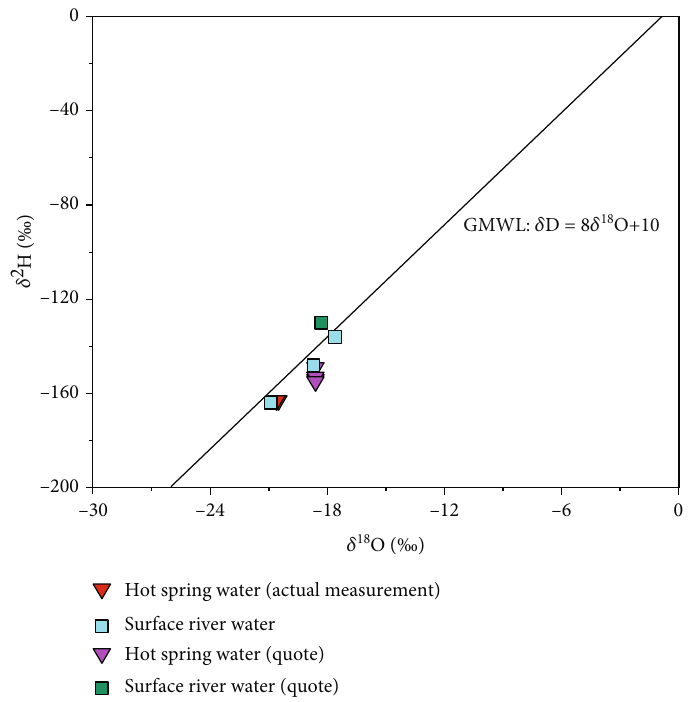
Figure 6: δ 2 H – δ 18 O isotope relationship of various water samples. Table 5: Calculated values of the geothermal fl uid replenishment elevation in the study area.